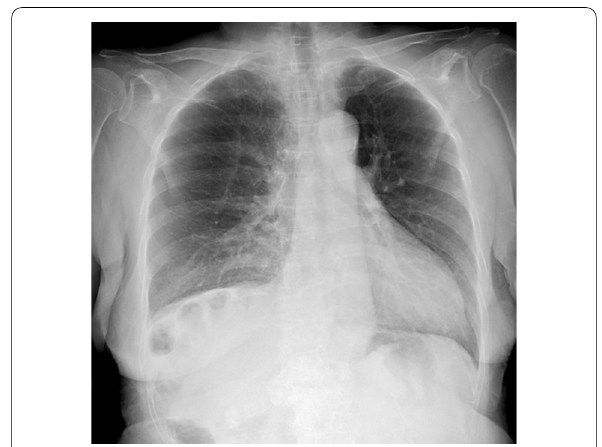
Fig. 1 Chest radiography. Chest radiography reveals a massive abnormal intestinal gas above the right lobe of the liver